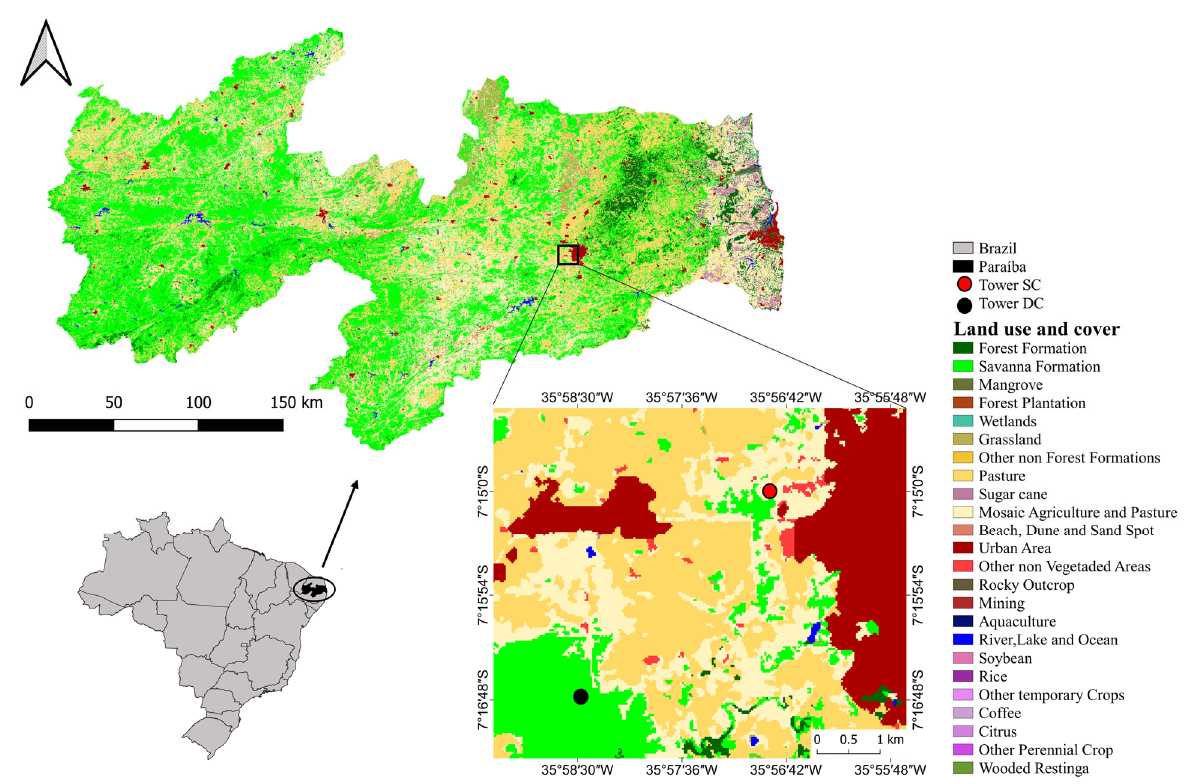
Figure 1. Land use and cover map of the study area and location of micrometeorological towers.